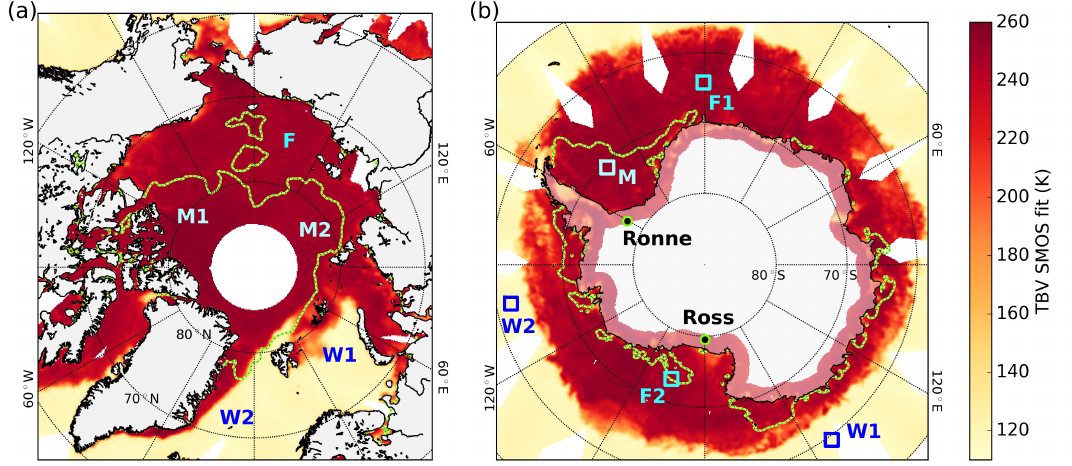
Figure 7. Overview maps of the study areas in the Arctic ( a ) and Antarctic ( b ). The colored areas are SMOS vertically polarized brightness temperatures using the wgzhao method on 1 March 2016 ( a ) and 1 October 2015 ( b ). White areas are missing data. The green contours denote the ice edge (15% SSM/I-ASI (Special Sensor Microwave/Imager using the ARTIST sea ice algorithm) ice concentration [28], obtained from the Integrated Climate Data Center, icdc.cen.uni-hamburg.de) during the month with minimum ice extend on 15 September 2016 ( a ) and 15 February 2016 ( b ). The dots mark the locations of stable targets over Antarctic ice shelves used in Section 3.1. The boxes indicate the study areas used in Section 3.2 over typical regions with water (W), first-year ice (F) and multi-year ice